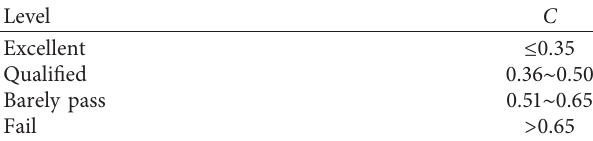
Table 2: Model grade classification table.